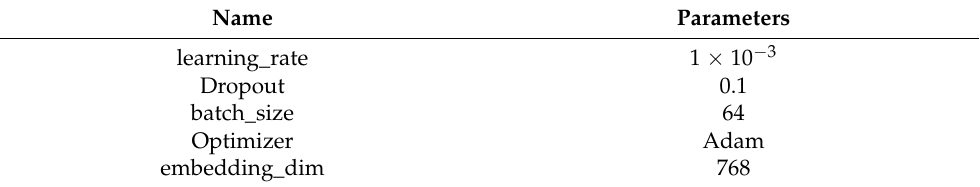
Table 1. Experimental parameter settings in this